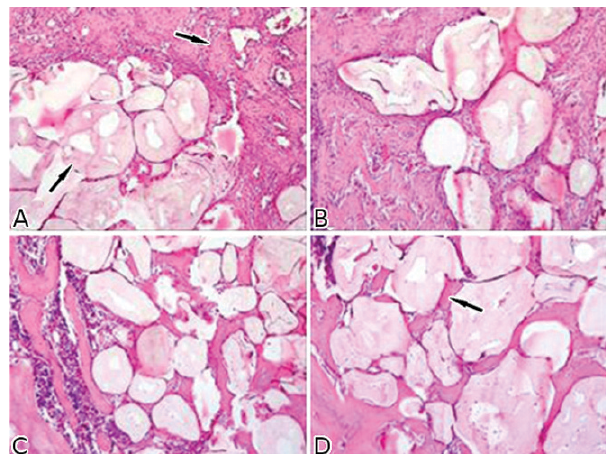
Figure 1 - Histology of a tibia implanted with vancomycin-loaded microspheres composed of PLLA/PEO: A) implant on the 4 th day, characterized by exuberant granulation tissue around the micro- spheres (Original H&E 20 6 ); B) implant on the 12 th day, showing remodeling into woven bone characterized by osteoblastic (arrow right) and osteoclastic (arrow left) activity (Original TM 40 6 ); and C and D) implants on the 8 th day, characterized by woven bone surrounding the microspheres that becomes mature when composed of lamellar bone at 32 weeks (Original TM 10 6 ).